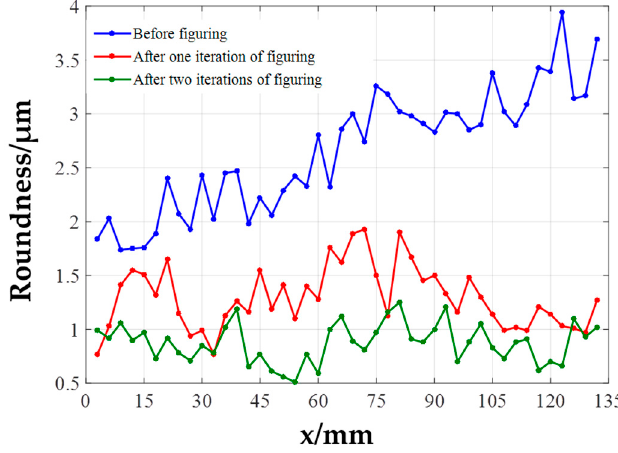
Figure 14. Roundness error at different axial positions.